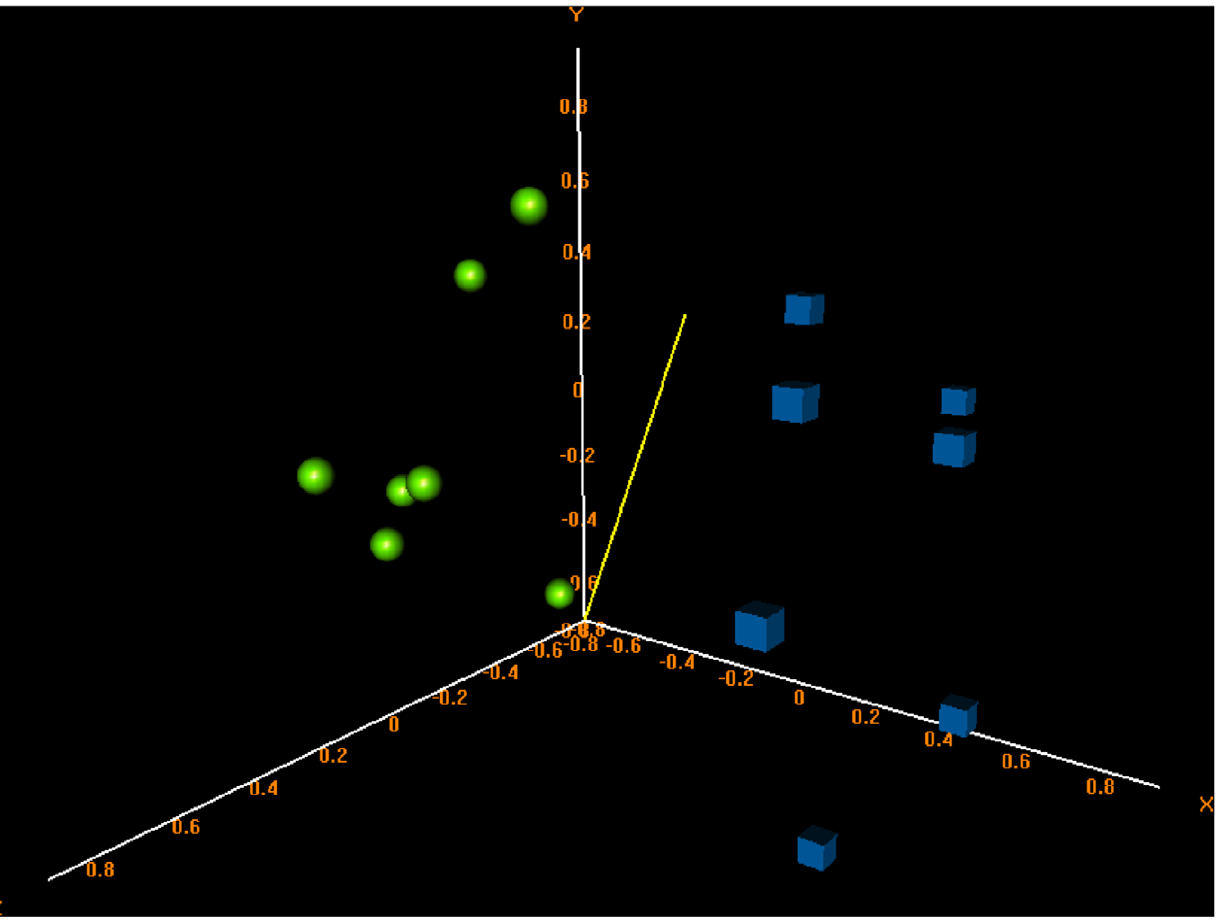
Figure 2. Multidimensional scaling of expression data. MDS of the expression profiles of ALS and controls shows the correct segregation of samples (see text for details). ALS samples are represented by spheres and controls by cubes.